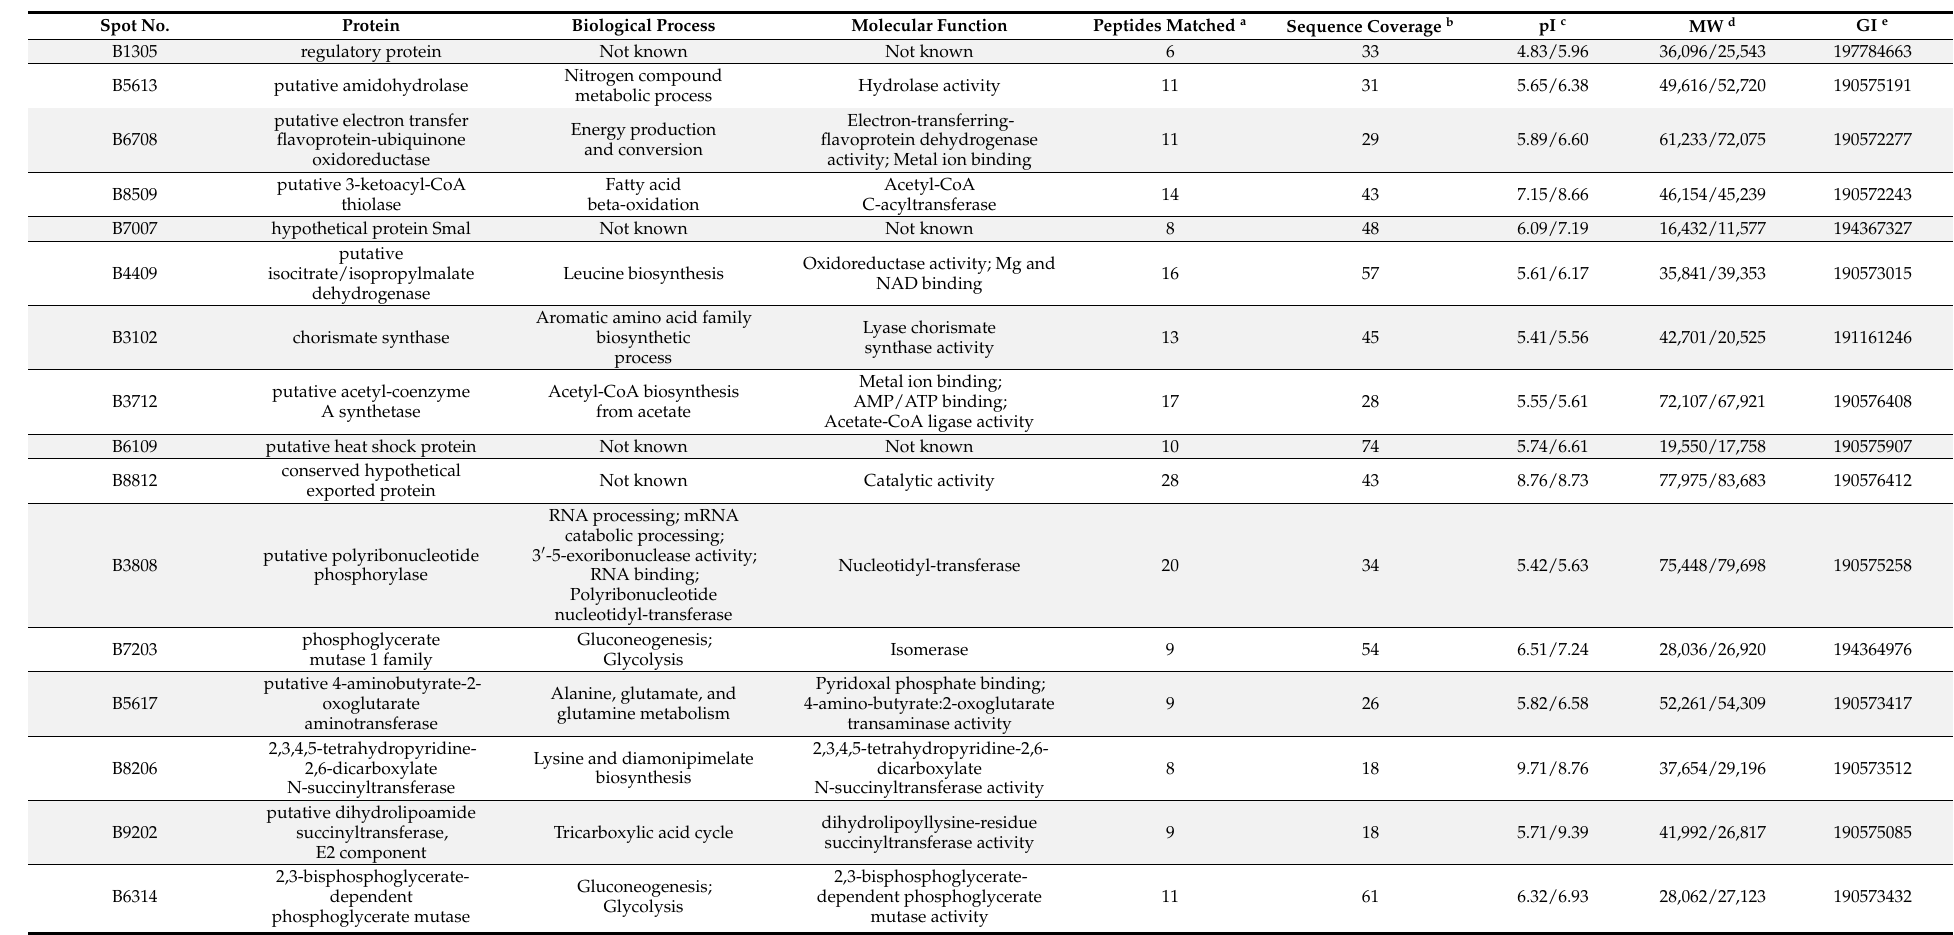
Table 1. Proteins (n = 16; signal >1000 ppm; p < 0.01, t -test) expressed only in biofilm-grown S. maltophilia Sm126